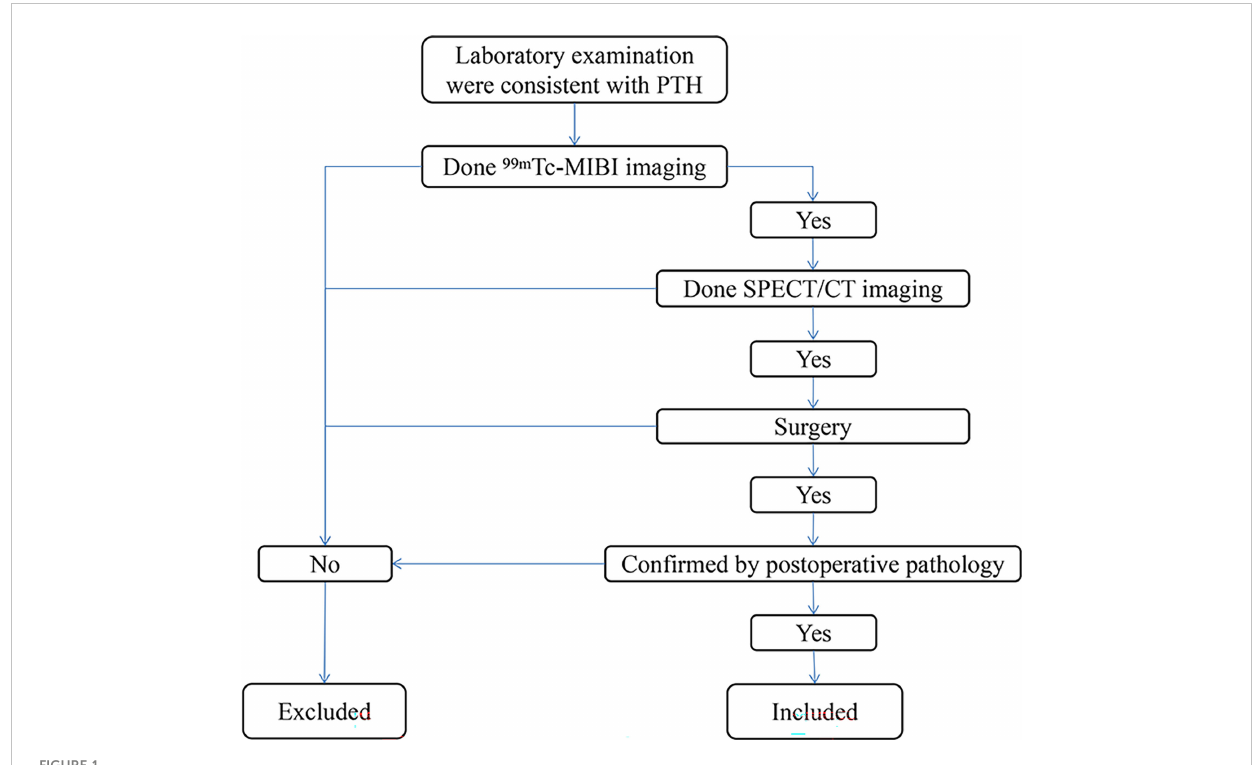
FIGURE 1 Inclusion and exclusion criteria